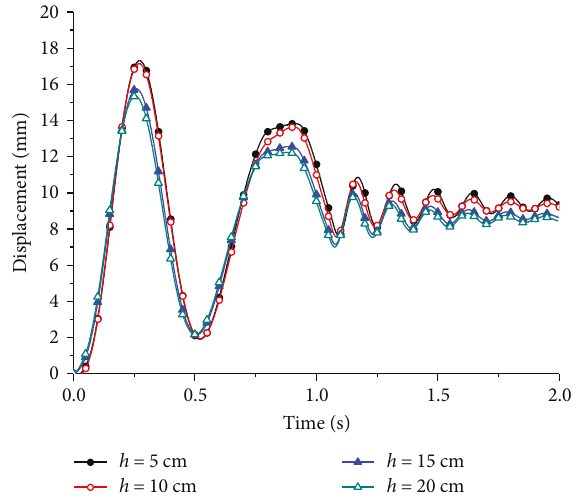
Figure 19: Vertical displacement of launch canister top in di ff erent surface layer thicknesses.